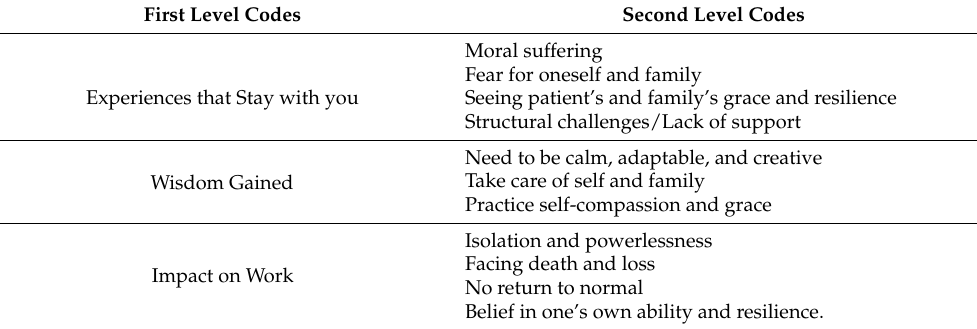
Table 1. First and Second Level